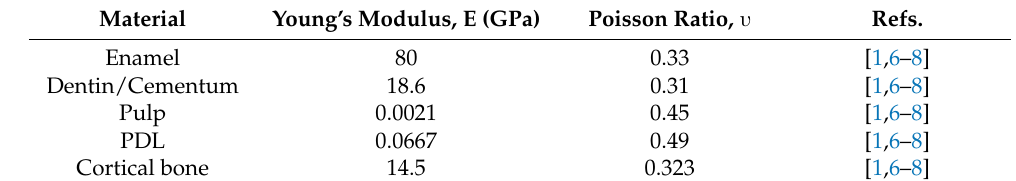
Figure 1. Mesh model of one of the nine patients involved in the study: ( A )—intact periodontium mesh model, ( B )—2nd lower right premolar model with intact periodontium and applied bracket, ( C )—intact PDL: ( D )—cervical third view of the intact PDL, ( E )—4 mm bone loss, ( F )—8 mm bone loss; ( G )—apical third view of the intact PDL with its neuro-vascular bundle; applied loads vectors: ( H )—intrusion, ( I )—extrusion, ( J )—translation, ( K )—rotation, and ( L )—tipping. Table 1. Elastic properties of materials in GPa.